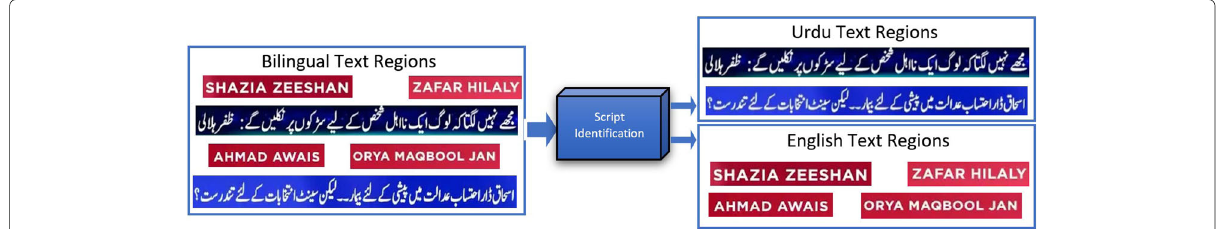
Fig. 9 Script Identification to separate text as a function of script